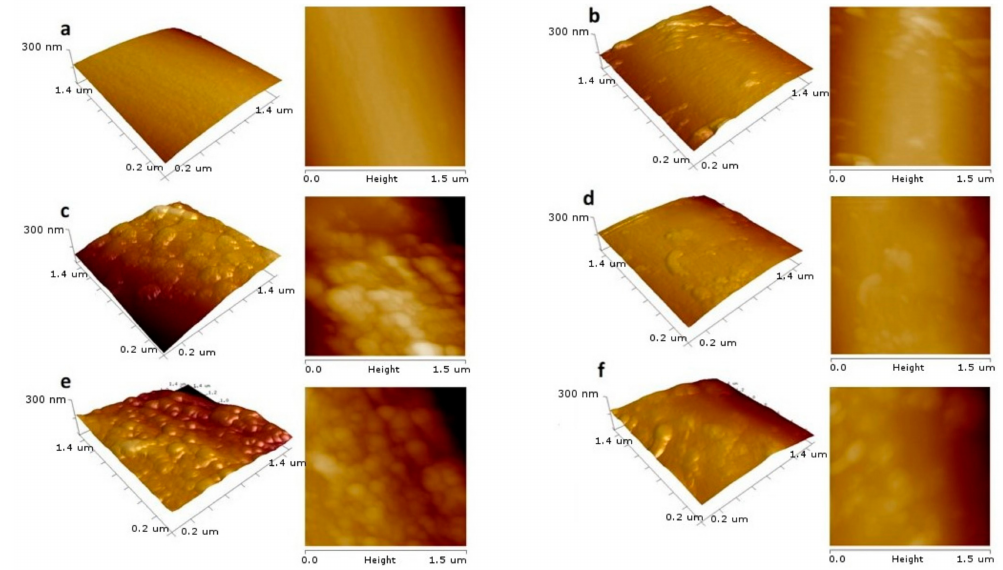
Figure 3. 2D and 3D height images of obtained surfaces from the AFM tapping-mode analysis, showing the influence of oxidation / unsheathing on the morphology of CNT layers created after the EPD process: